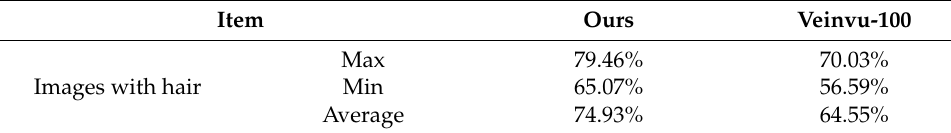
Figure 17. Proposed Algorithm Operation SSIM Measurement Results. Table 3. Proposed Algorithm SSIM Similarity Verification